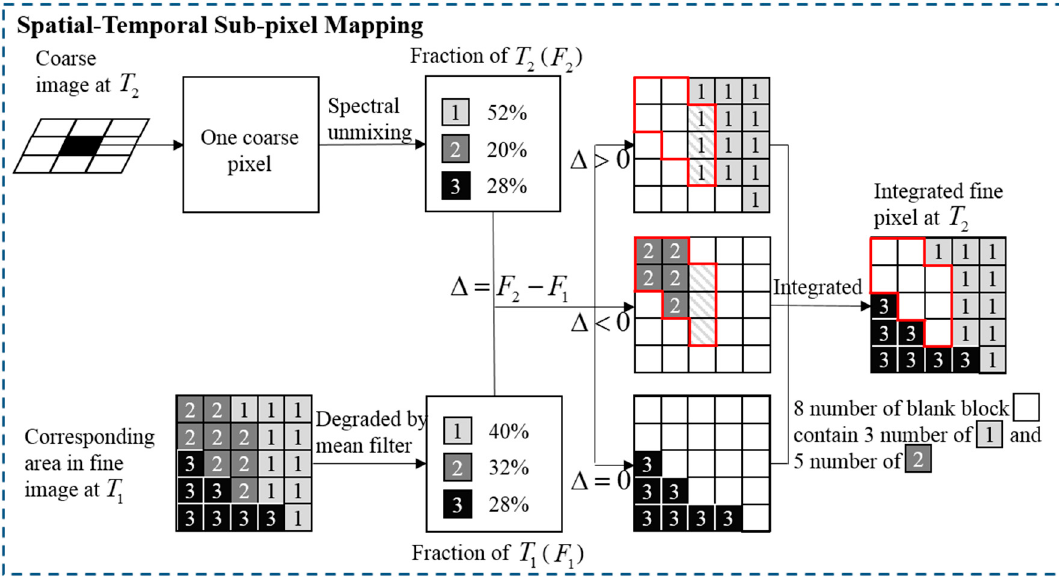
Figure 6. The framework of spatial-temporal sub-pixel mapping.